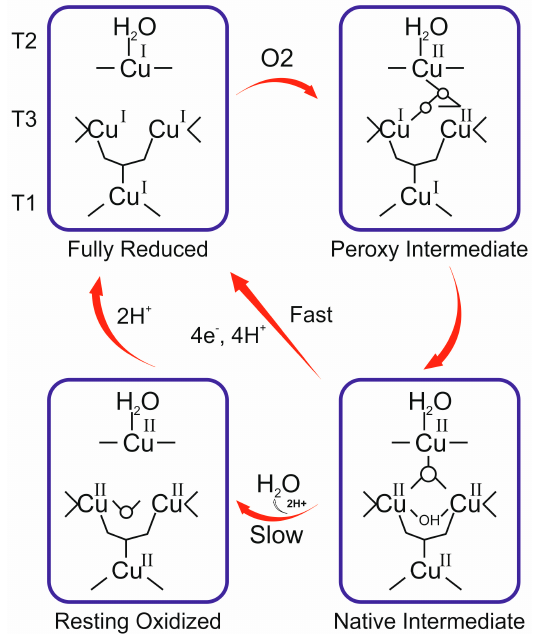
Figure 1. General mechanism of the reaction of bacterial laccases (adopted from [17]).